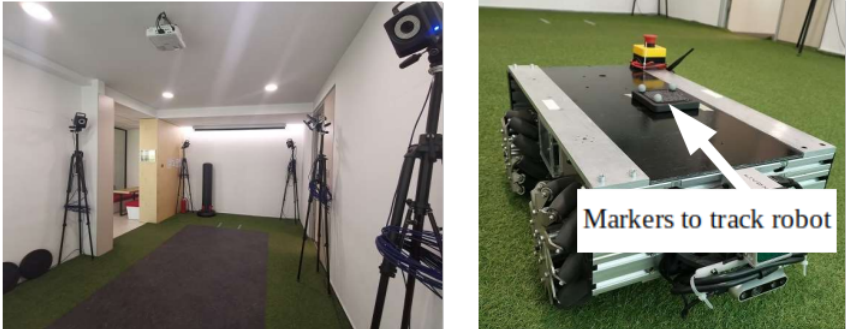
Figure 4. Experimental setup with Vicon motion capture and reflective markers for evaluation RTAB-SLAM localization in the indoor environment.